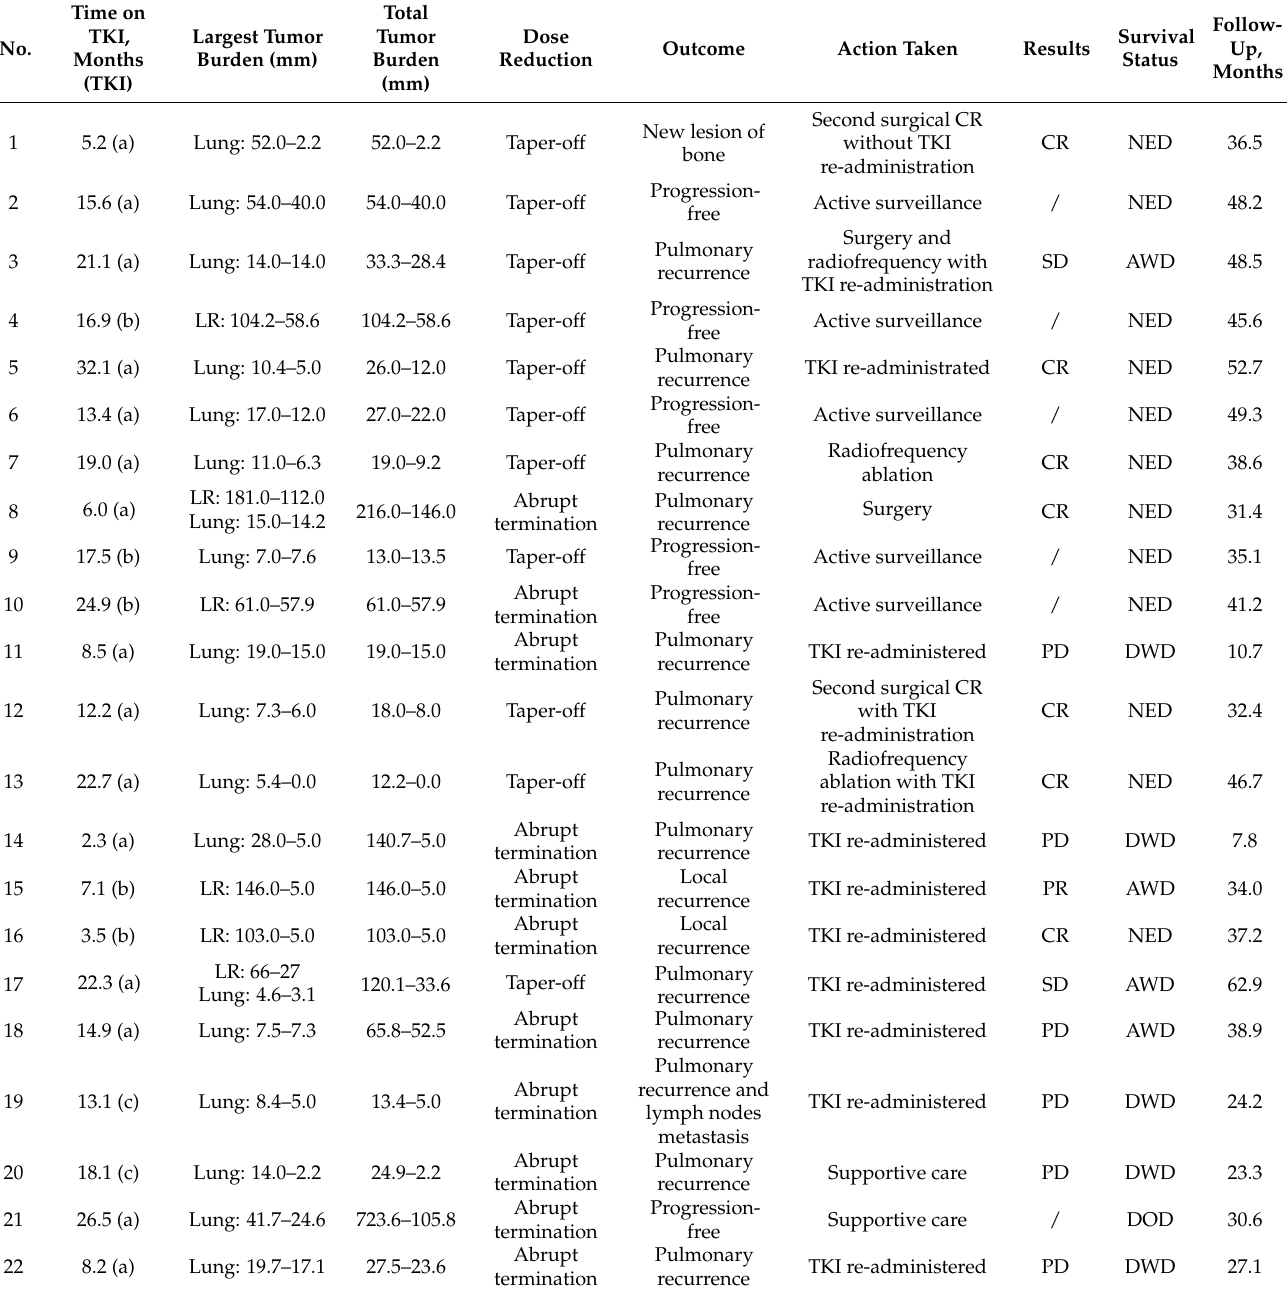
Table 2. Clinical and oncological data for the 22 patients’ outcomes following AA-TKI